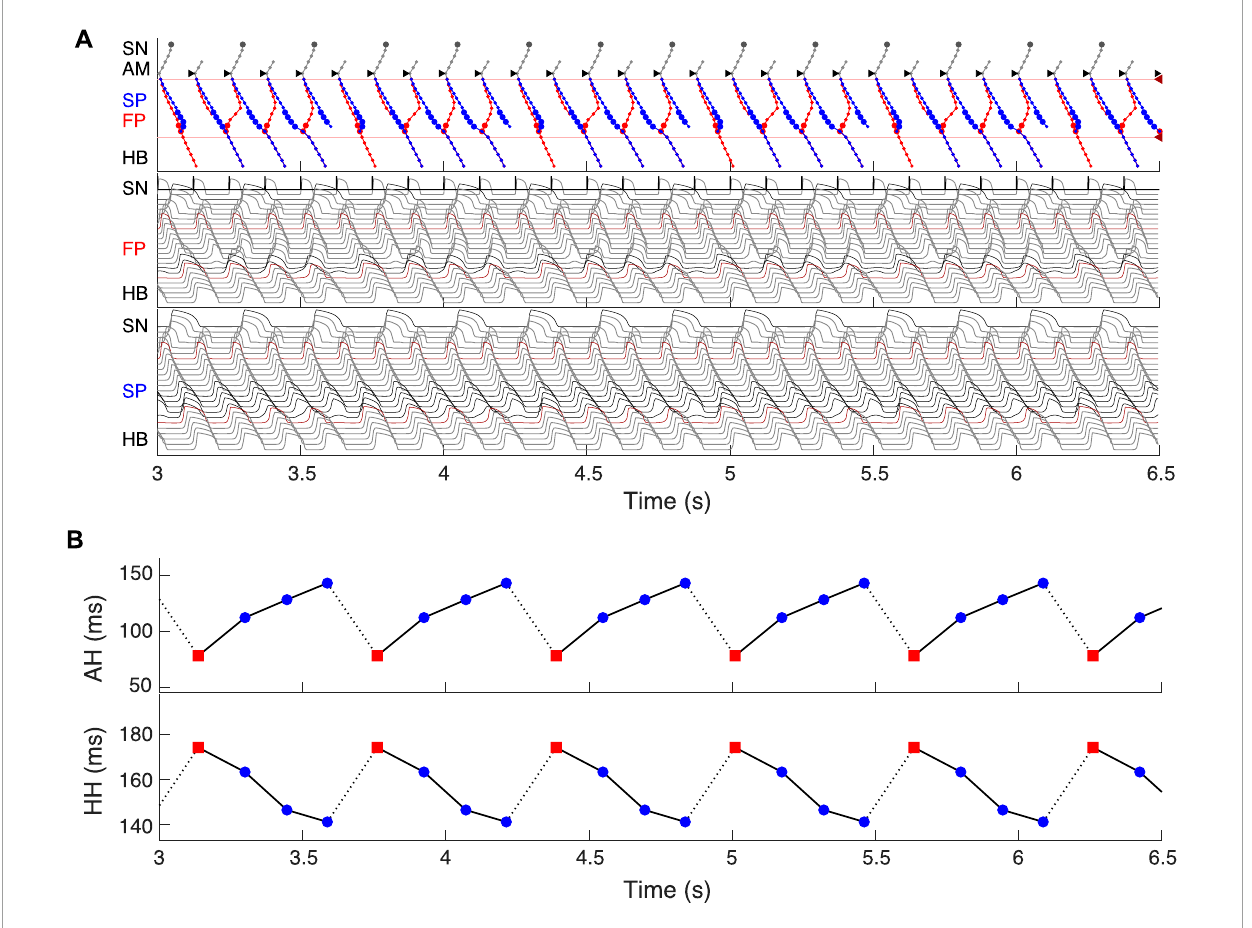
FIGURE 13 Simulated 5:4 Wenckebach pattern (atrial/His rates 480/384 bpm) at regular atrial pacing (atrial flutter) with the interval of 125.2 ms. (A) Laddergram and action potential propagation through the FP and SP. (B) AH conduction time of consecutive beats in the Wenckebach cycle (top panel), and HH interval (bottom panel). Each Wenckebach cycle begins with FP conduction (red squares), AH delays progressively prolonged, and HH intervals progressively